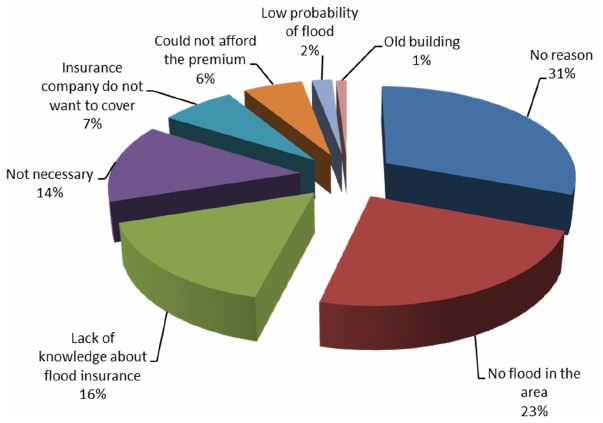
Figure 1. Reasons for not purchasing flood